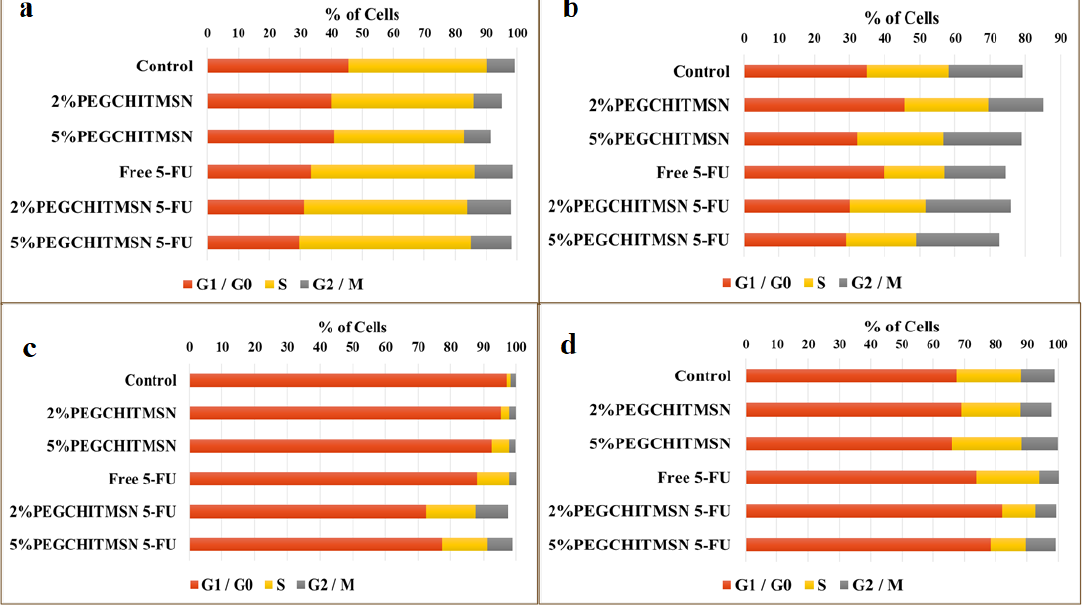
Figure 11. Cell cycle distribution in ( a ) HEK293, ( b ) Caco-2, ( c ) MCF-7, and ( d ) HeLa cells.